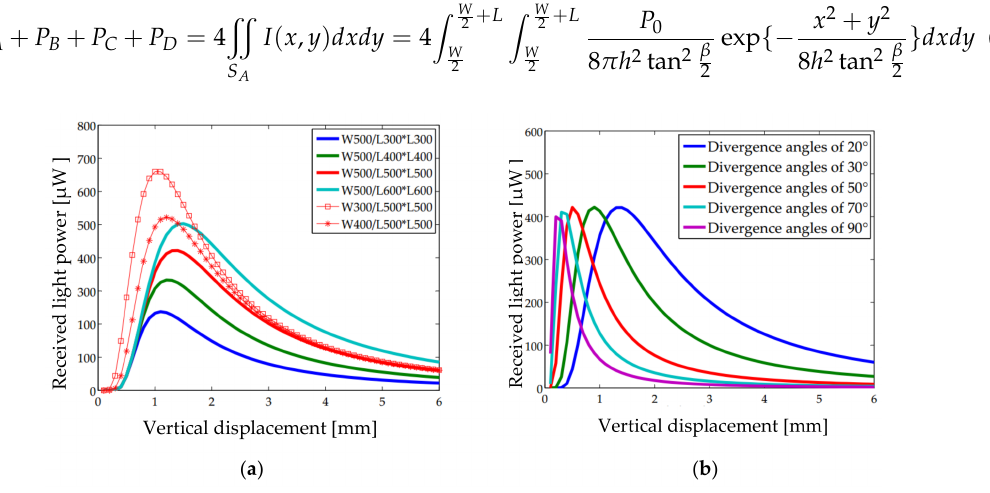
Figure 4. Received light power versus vertical displacement. ( a ) Different W & L with the divergence angle of 20 ◦ ; ( b ) Different divergence angles with W of 500 µ m and L of 500 µ